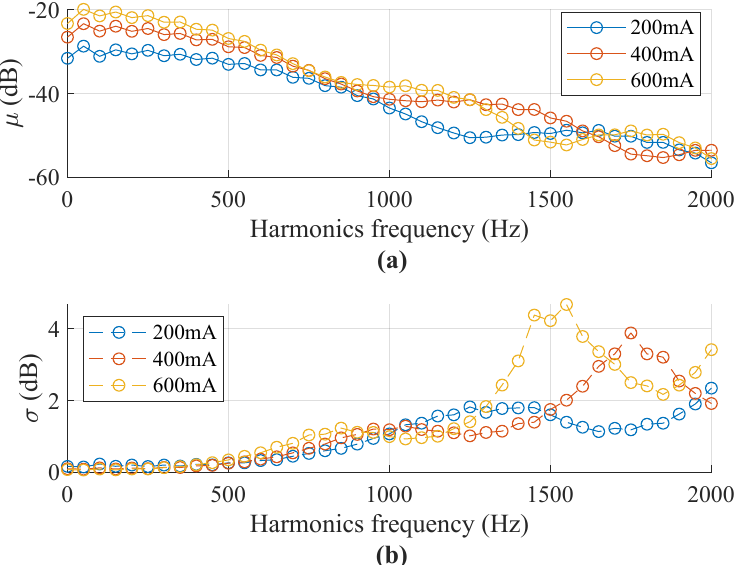
Figure 6. Lognormal distribution parameters as a function of frequency for different load levels: ( a ) µ dB and ( b ) σ dB